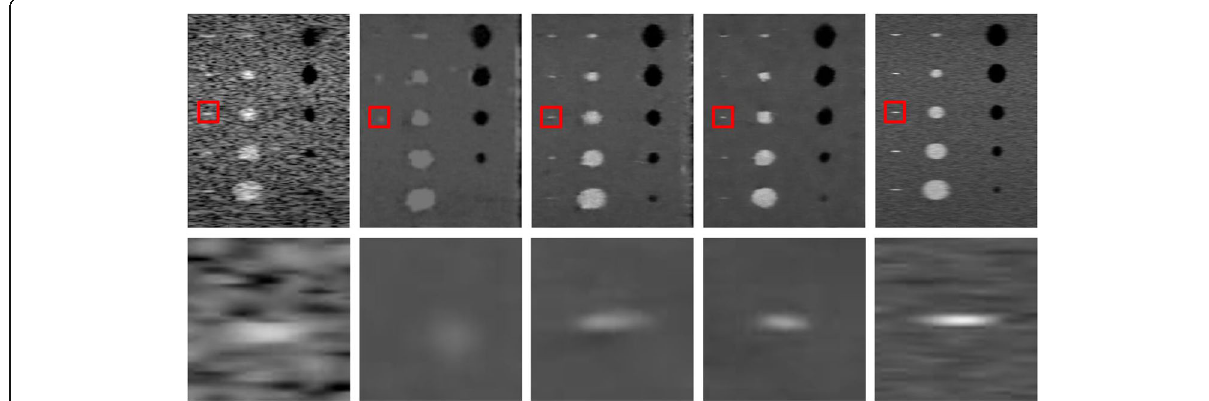
Fig. 4 Results on simulation dataset. On the first line from left to right are low-quality image, encoder-decoder result, U-Net result, SSC U-Net result, and high-quality image. The second line shows the image in the corresponding red box in the first